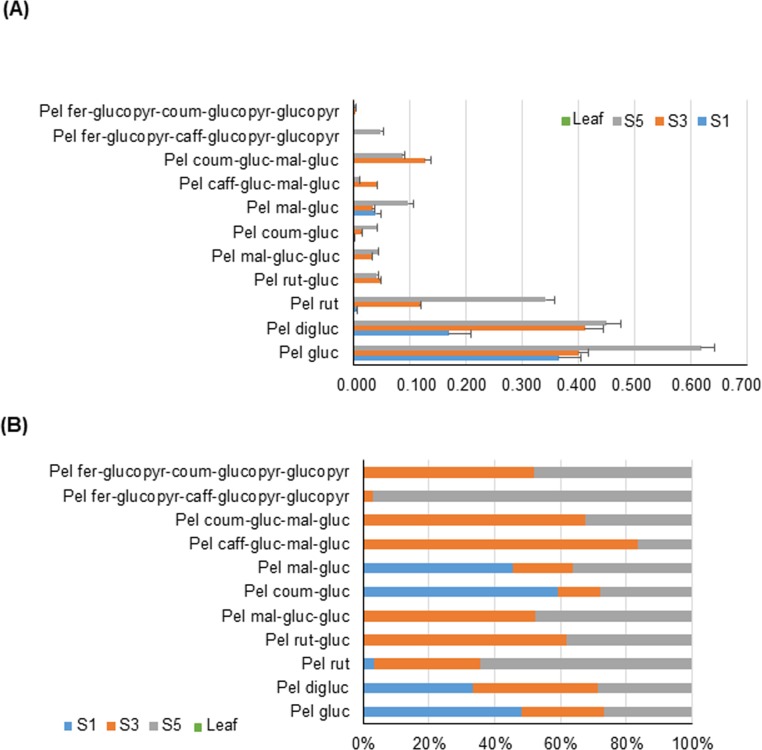
Levels of pelargonidin derivatives identified in leaf and petals of Gentiana lutea L. var. aurantiaca in three different developmental stages by HPLC-ESI-MS/MS analyses.(A) Data are expressed as average and standard deviation which represent, for each anthocyanin metabolite, the fold over the internal standard (IS), have been obtained by using, at least, 3 independent biological replicates. For more details, see Materials and Methods. (B) Percent relative abundance of each anthocyanin among the three developmental stages (S1, S3, S5) under study. Abbreviations: Pel coum-gluc, Pelargonidin 3-O-(6-p-coumaroyl)glucoside; Pel digluc, Pelargonidin 3,5-O-diglucoside; Pel caff-gluc-mal-gluc, Pelargonidin 3-O-(6-O-caffeoyl-D-glucoside)-5-O-(6-O-malonyl-β-D-glucoside); Pel fer-glucopyr-caff-glucopyr-glucopyr, Pelargonidin 3-O-[2-O-(6-(E)-feruloyl-β-D-glucopyranosyl)-6-O-(E)-caffeoyl-β-D-glucopyranoside]-5-O-(β-D-glucopyranoside); Pel fer-glucopyr-coum-glucopyr-glucopyr, Pelargonidin 3-O-[2-O-(6-(E)-feruloyl-β-D-glucopyranosyl)-6-O-(E)-p-coumaroyl-β-D-glucopyranoside]-5-O-(β-D-glucopyranoside); Pel gluc, Pelargonidin 3-O-glucoside; Pel mal-gluc, Pelargonidin 3-O-(6-O-malonyl-β-D-glucoside); Pel rut, Pelargonidin 3-O-rutinoside; Pel rut-gluc, Pelargonidin 3-O-rutinoside-5-O-β-D-glucoside; Pel mal-gluc-gluc, Pelargonidin 3-O-(6-O-malonyl-β-D-glucoside)-5-β-D-glucoside; Pel coum-gluc-mal-gluc, Pelargonidin 3-O-(6-p-coumaroyl-D-glucoside)-5-(4-O-malonyl-β-D-glucoside).